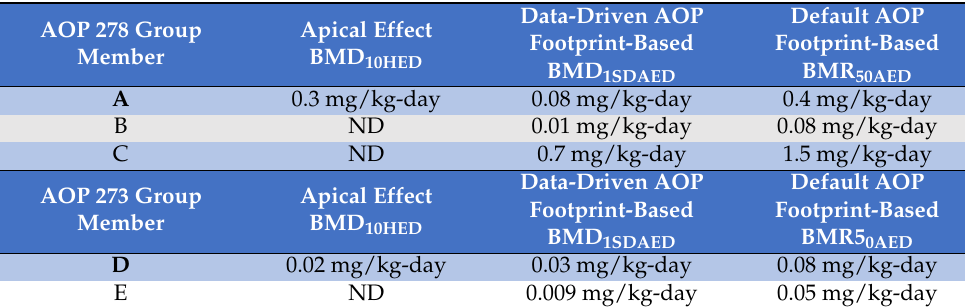
Table 2. Component chemical BMDs for a hypothetical mixture of components A–E. Human equivalent BMDs are modeled at a BMR appropriate for the apical effect type (e.g., BMR 10 for inci- dence of liver injury). BMDs are calculated for the AOP footprint event(s) based on the converted administered equivalent dose (AED)-response (note: an AED is an estimated oral exposure dose that results in an internal steady-state concentration in humans consistent with the in vitro con- centration associated with a biological perturbation or activity). The preferred NAM-based BMR is data-driven/expert-selected, in this example set at one standard deviation (1SD) change over corresponding control; the BMR 50 is also provided as a comparator however it is not required to carry the default-based BMDs further unless desired by the user. The numerical values provided are hypothetical and for illustrative purposes only.